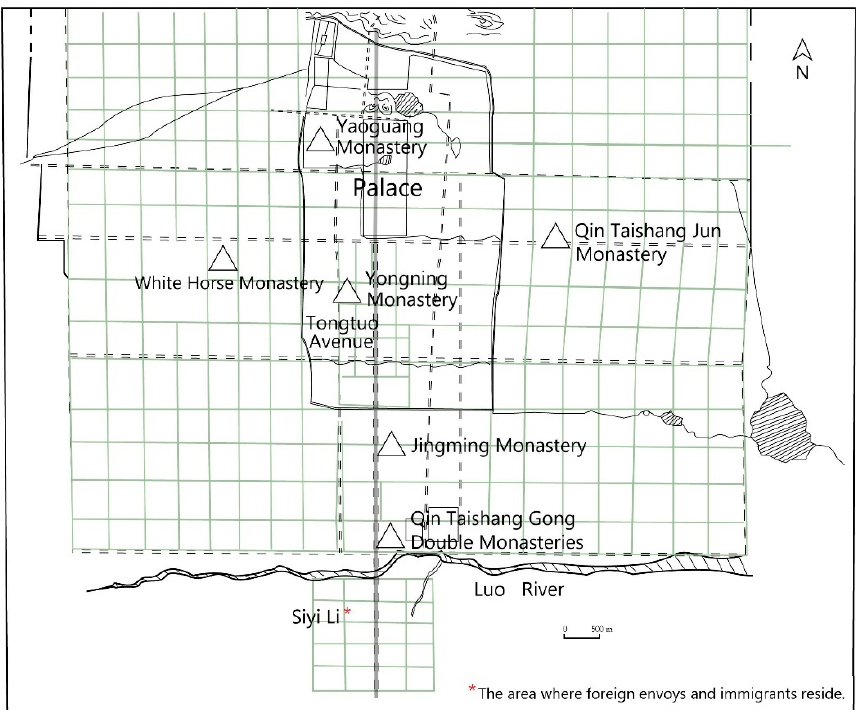
Figure 1. Schematic diagram of the locations of the main Buddhist monasteries in Luoyang in the Northern Wei. 9